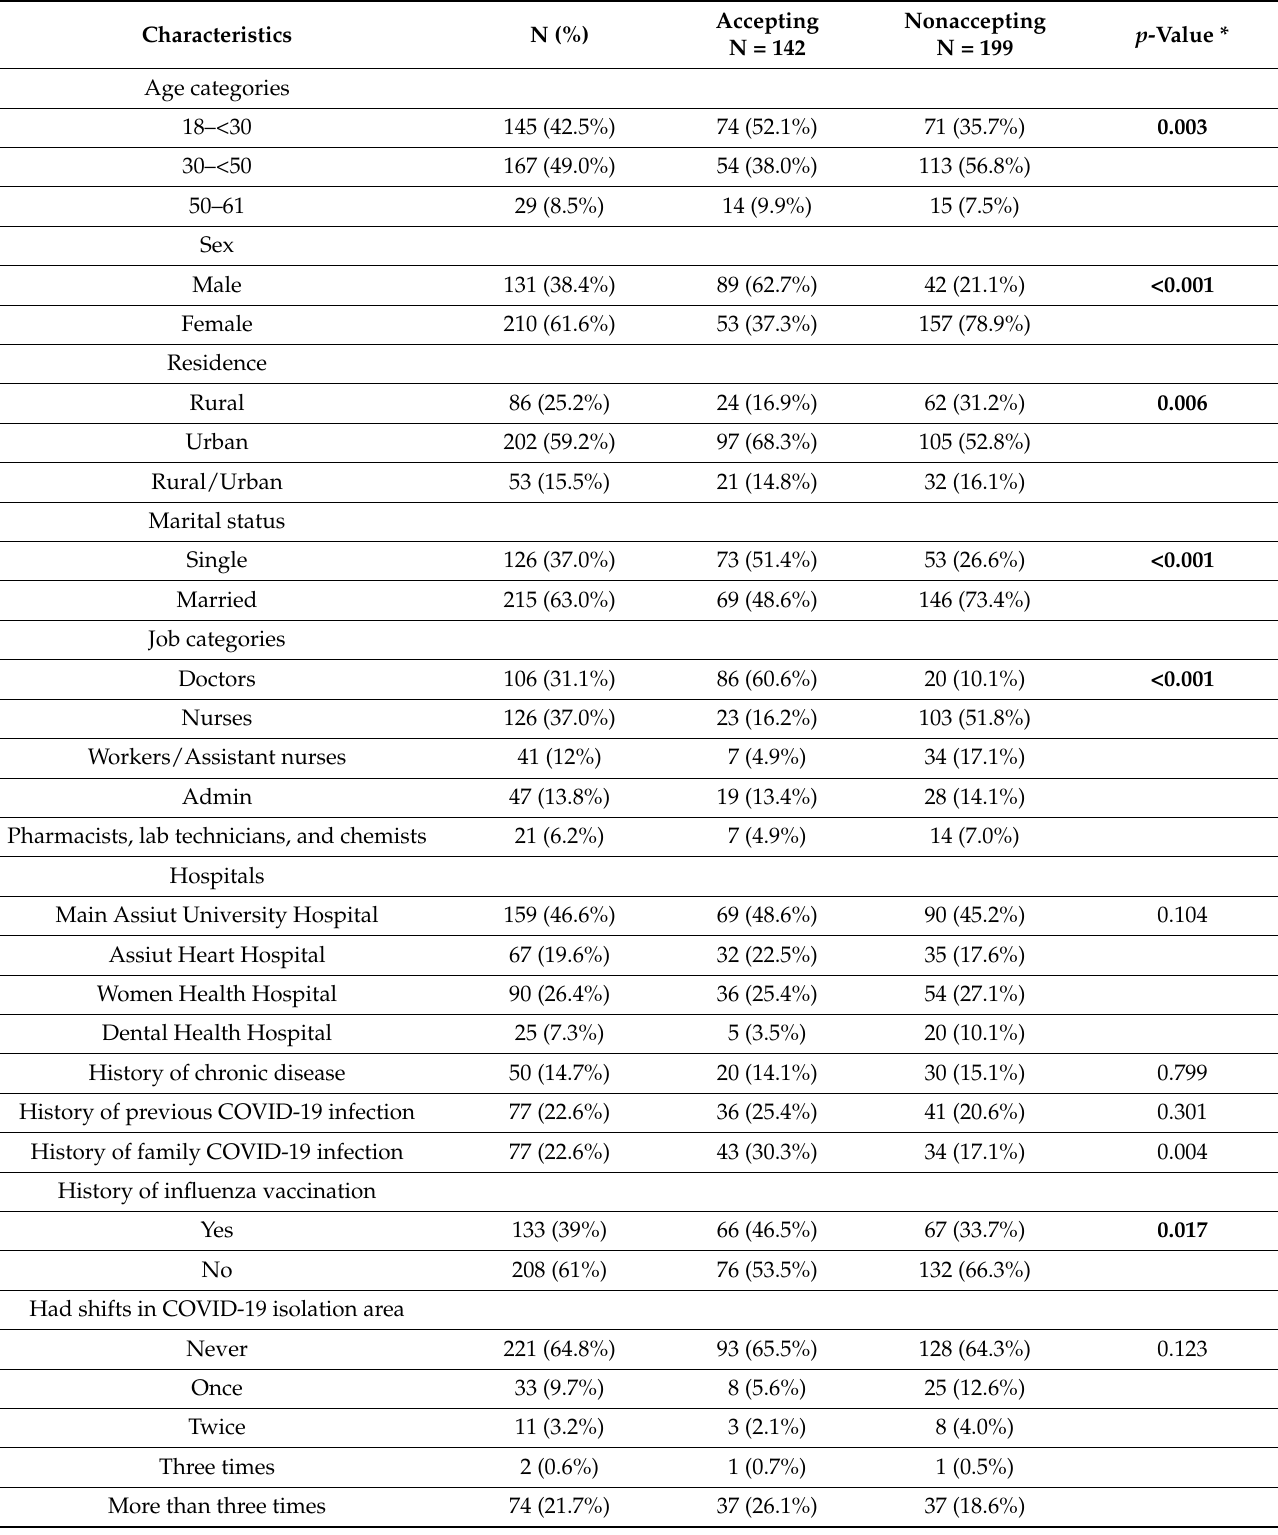
Table 1. Sociodemographic, job categories, chronic diseases, previous COVID-19 infection and exposure, and main sources of information differences among accepting and nonaccepting HCWs to COVID-19 vaccine (N =